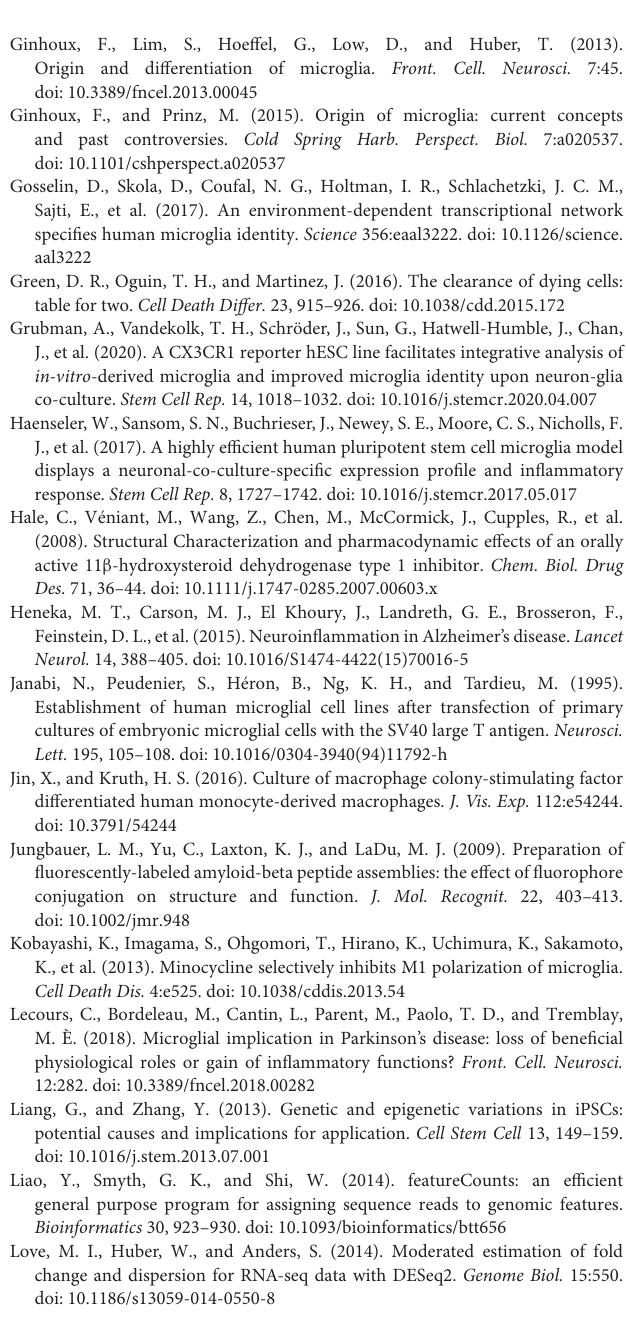
Supplementary Figure 2 | Principal component analysis (PCA) from RNA-seq profile. PCA plot of monocytes, iMacs, and iMG cells from whole-genome RNA-seq profile. Supplementary Figure 3 | Upregulation of microglia-specific genes and AD risk genes in iMG Cells. Four genes mentioned as being mice microglia-specific in